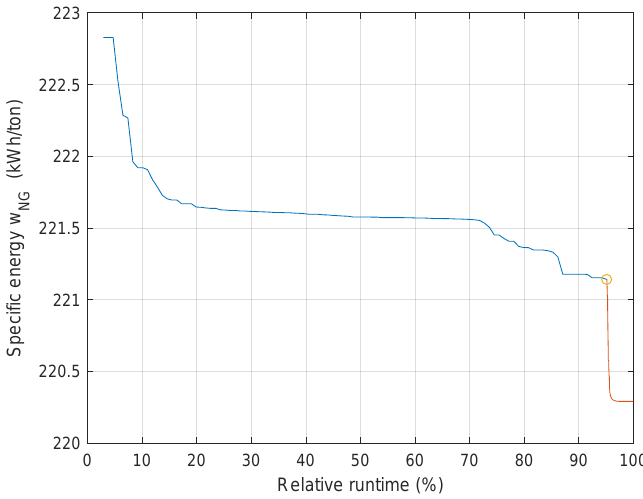
Figure 5. Computer runtime for the hybrid optimization approach with ga ( blue ) and fminsearch ( red